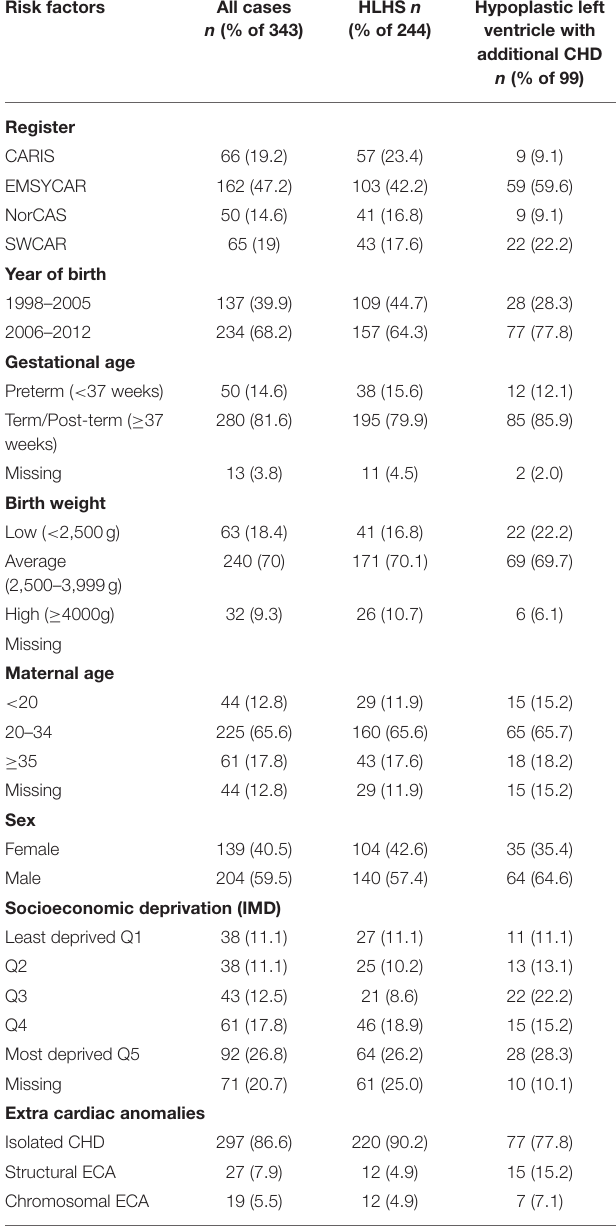
TABLE 2 | Kaplan-Meier survival estimates for HLHS and hypoplastic left ventricle TABLE 1 | Birth characteristics of cases of HLHS and hypoplastic left ventricle with additional CHD born between 1998 and 2012. with additional CHD. Risk factors All cases HLHS n Hypoplastic left Age All cases n (% of 343) (% of 244) ventricle with Survival additional CHD (95% n (% of 99)